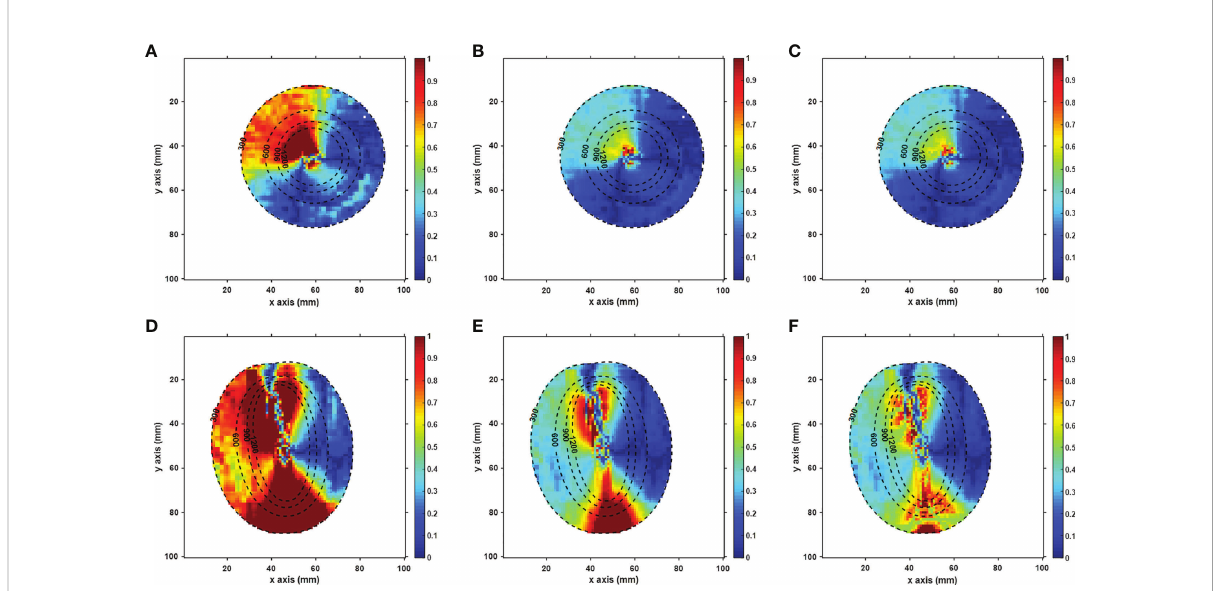
FIGURE 5 Axial (A – C) and sagittal (D – F) views of the gamma-index map of the RD_cor. In the gamma calculation, the distance and dose criteria were set to (1%, 1 mm) in a and d fi gures, (2%, 1 mm ) in b and e fi gures, (2%,2 mm) in c and f fi gures, respectively, and the voxels with doses less than 3 Gy were not included. The dotted lines indicate the dose contour (unit: